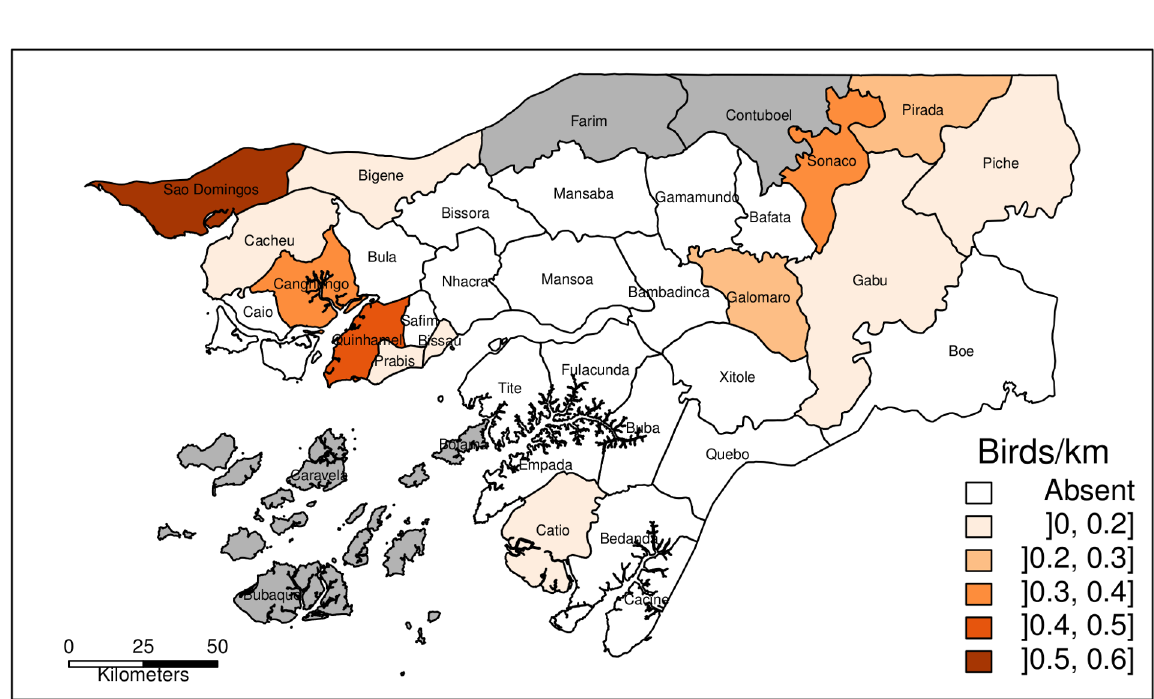
Fig 3. Abundance of African white-backed and Ru¨ppell’s vultures. Abundance of Gyps spp . in sampled Sectors of Guinea-Bissau obtained from road survey transects. Gyps spp . consist mostly of African white-backed vultures. Grey areas represent Sectors that were not sampled ( Gyps spp . were never observed in the Bijago´s archipelago; authors pers.